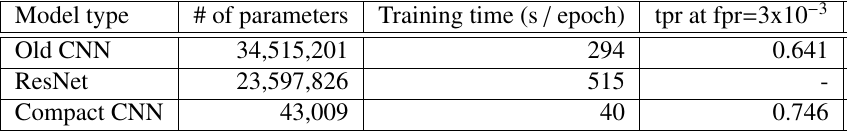
Table 2: Comparison of selected trained models. tpr and fpr stand for true positive rate and false positive rate respectively. Old CNN denotes the CNN used in the previous work, Compact CNN is the best performing CNN in this work. We also compare these with a ResNet model. The training times are obtained by running on a Titan X (Pascal)